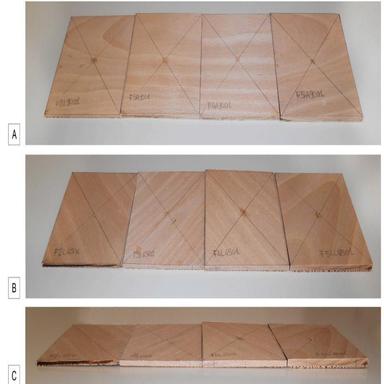
A: different specimens of the "90 configuration"; B: different specimens of the "45 configuration"; C: comparison of different thicknesses.